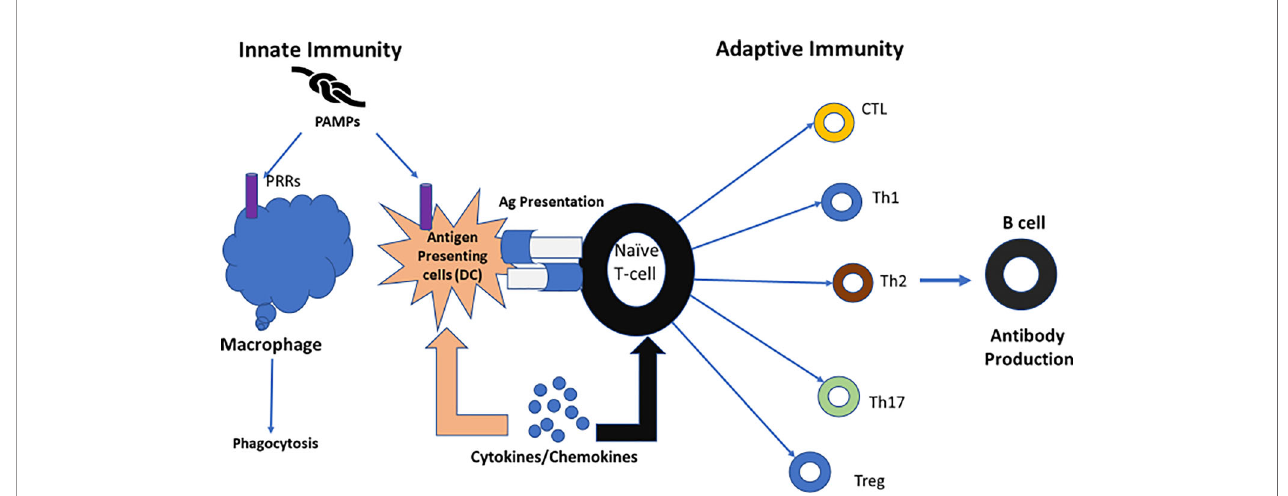
FIGURE 7 | The role of dendritic cells; linking innate immunity and adaptive immunity. [Reproduced from (89)]. One key role of dendritic cells is linking innate immunity to adaptive immunity. When confronted with microbial antigens, dendritic cells (DCs) mature and migrate into draining lymph nodes where they present antigens to naïve T lymphocytes. Different pathogens trigger distinct dendritic cell maturation pro fi les and lead to the polarization of different T-cell subsets. Then, the adaptive immune response is modulated to match the nature of the pathogen (89). Ag, antigen; CTL, cytotoxic T cell; DC, dendritic cell; PRRs, Pattern recognition receptors; PAMPs, Pathogen associated molecular patterns. Figure from Intechopen (89) permissible to reuse under a CC-BY 4.0 license.